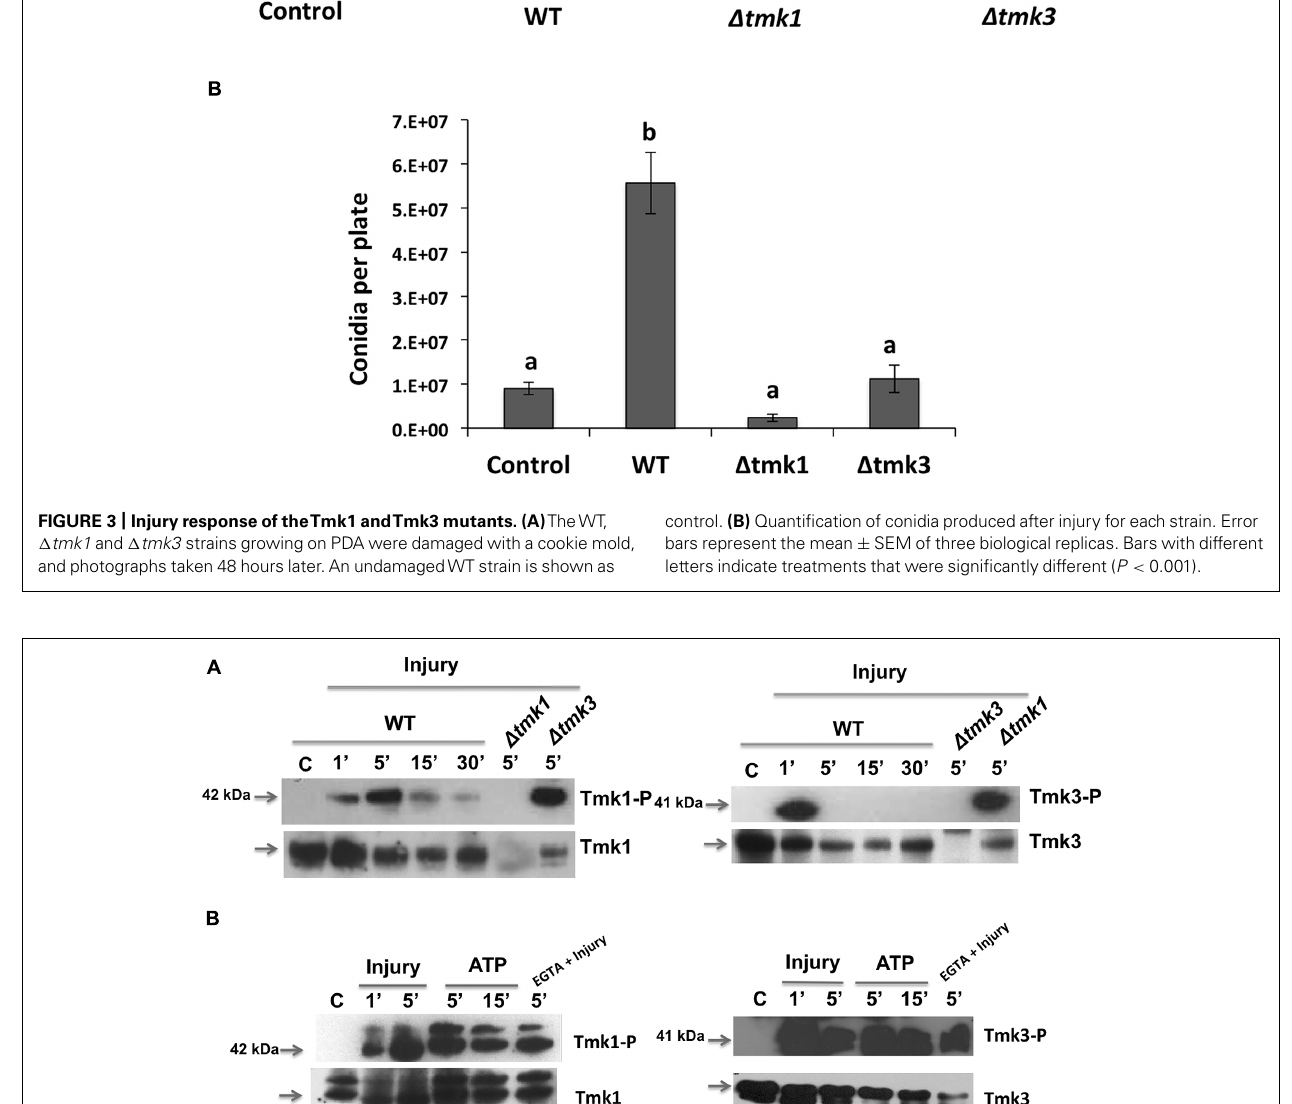
recognize Tmk2 (p44), as previously shown (Mendoza-Mendoza etal., 2003). (B) The WT strain was ATP induced (0.1 mM) or treated with EGTA (15 mM) and mycelial samples collected at the indicated times. Proteins were extracted, separated by SDS-PAGE, and used for immunoblotting. Blots were probed as in (A) . Arrows indicate the bands corresponding to Tmk1 or Tmk3. The (cid:2) tmk1 and (cid:2) tmk3 mutants were included as controls. The experiments were repeated three times with similar